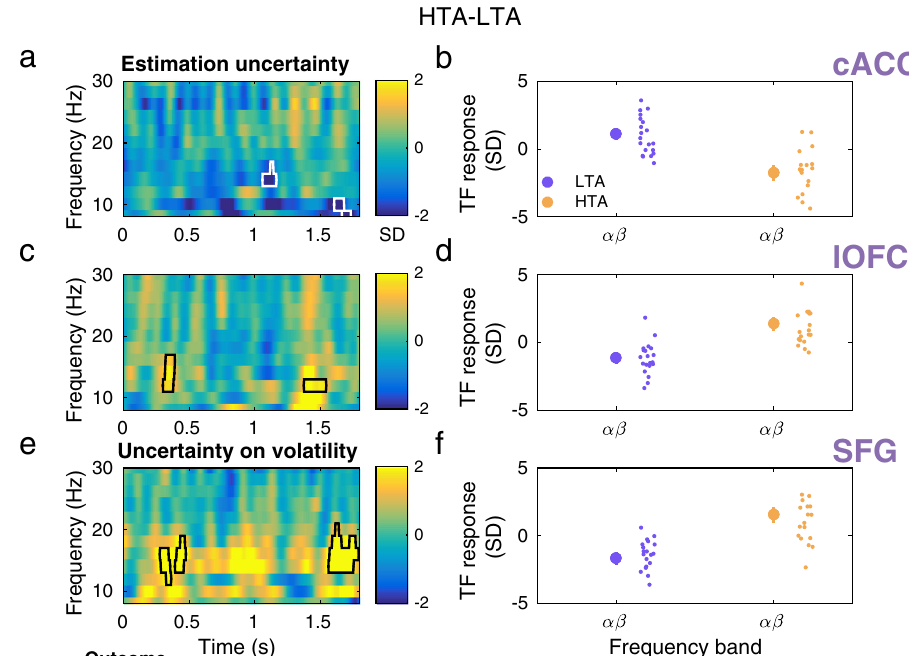
Fig. 5 Modulation of alpha and beta activity during the representation of uncertainty in high trait anxiety. a To investigate the effect of trait anxiety on the neural oscillatory correlates of precision weights modulating the in fl uence that PEs have on updating predictions on each level, we included σ 2 and σ 3 as additional parametric regressors in our main GLM. Informational uncertainty, σ 2 , is the precision ratio updating beliefs on level 2. For level 3, the precision ratio is proportional to the uncertainty about volatility, σ 3 (inverse precision on level 3: 1/ π 3 ; Eq. 1) The model also included continuous regressor | ε 2 | and discrete regressors coding for outcome events (win, lose, no response). TF images were normalised with the mean and standard deviation (SD) of the activity from − 300 to − 50 ms before the outcome feedback, and thus are given in SD units. In the caudal ACC (cACC), the representation of precision weights σ 2 was associated with a relative reduction of higher alpha and low beta activity in high trait anxiety, at latencies that were aligned with the gamma effects in Fig. 3 (~1.1 and 1.6 s; P = 0.01, FWER-controlled). b Average activity in the signi fi cant spectrotemporal clusters in a) separately for each